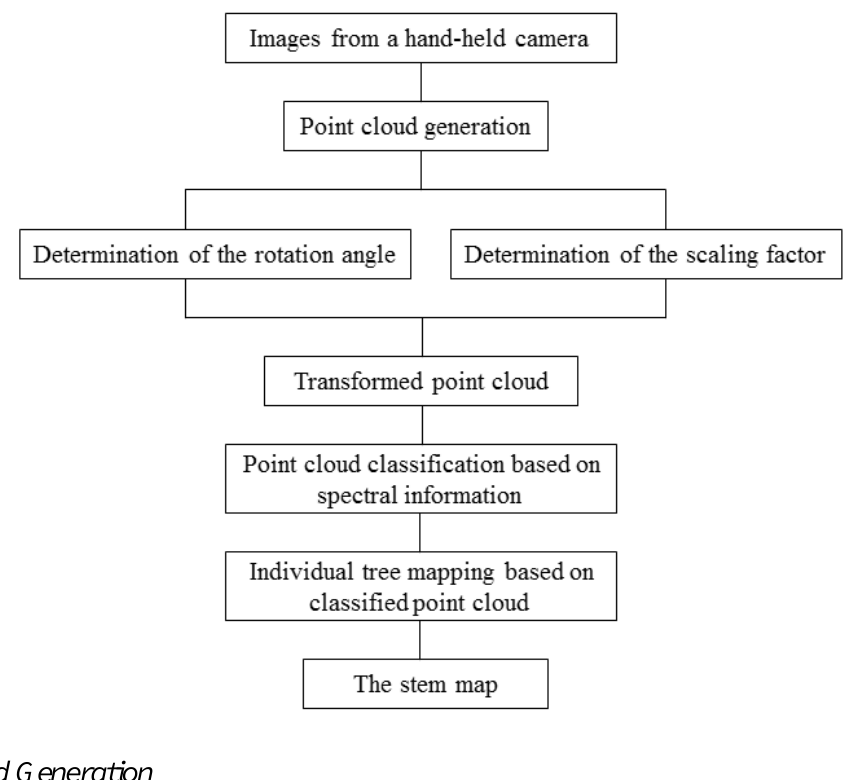
Figure 2 . The flow chart of the data processing using a hand-held